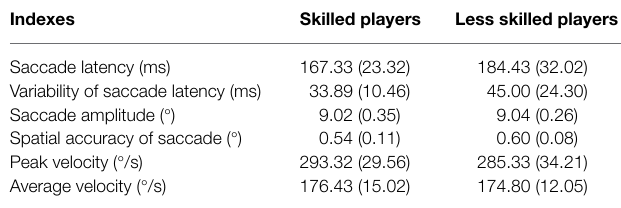
TABLE 2 | Mean (SD) of saccadic eye movement indexes in prosaccade task for two groups of